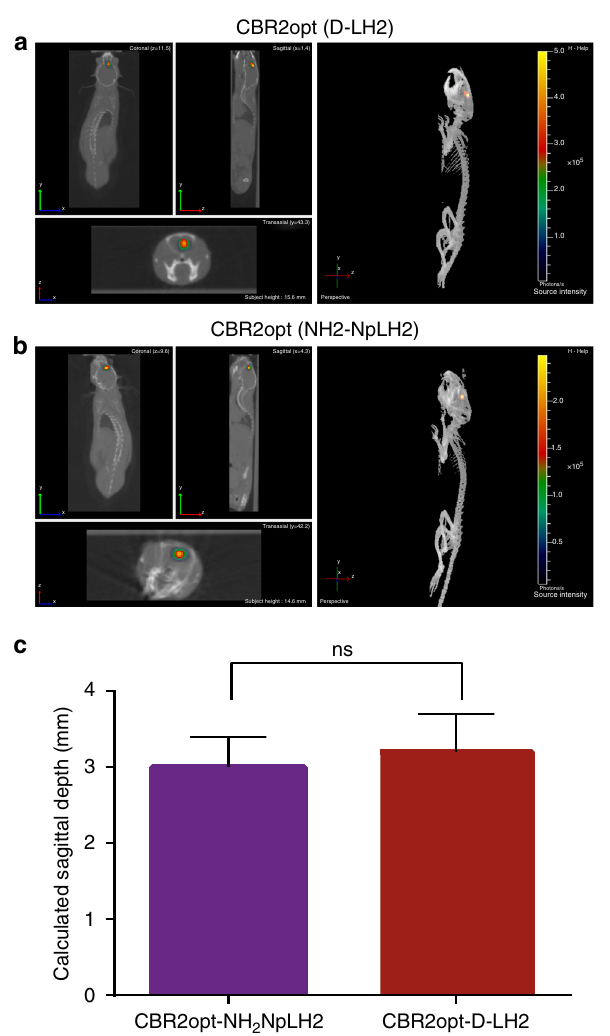
Fig. 5 Bioluminescence tomography in mouse brain showing the location of the bioluminescence signal in mouse brain at day 1 after transplantation of cells. The images were acquired 10 min after intraperitoneal injection of NH 2 -NpLH2 (220 mg kg − 1 ) or D-LH2 (300 mg kg − 1 ) using respectively band pass fi lters 700 nm, 720 nm, and 740 nm or 580 nm, 600 nm, and 620 nm for each mouse. Acquisition time was 30 s. After BLI mice kept in the dedicated coil were placed in the CT scanner. a Co-registered CT and BLT images using CBR2opt/D-LH2 pairing (sagittal section and reconstruction). b Co-registered CT and BLT images using CBR2opt/NH 2 - NpLH2 pairing (sagittal section and reconstruction). c Quanti fi cation of depth from skull surface indicated no signi fi cant difference (ns) between substrates when using the single point light source ( n = 3). Error bars represent